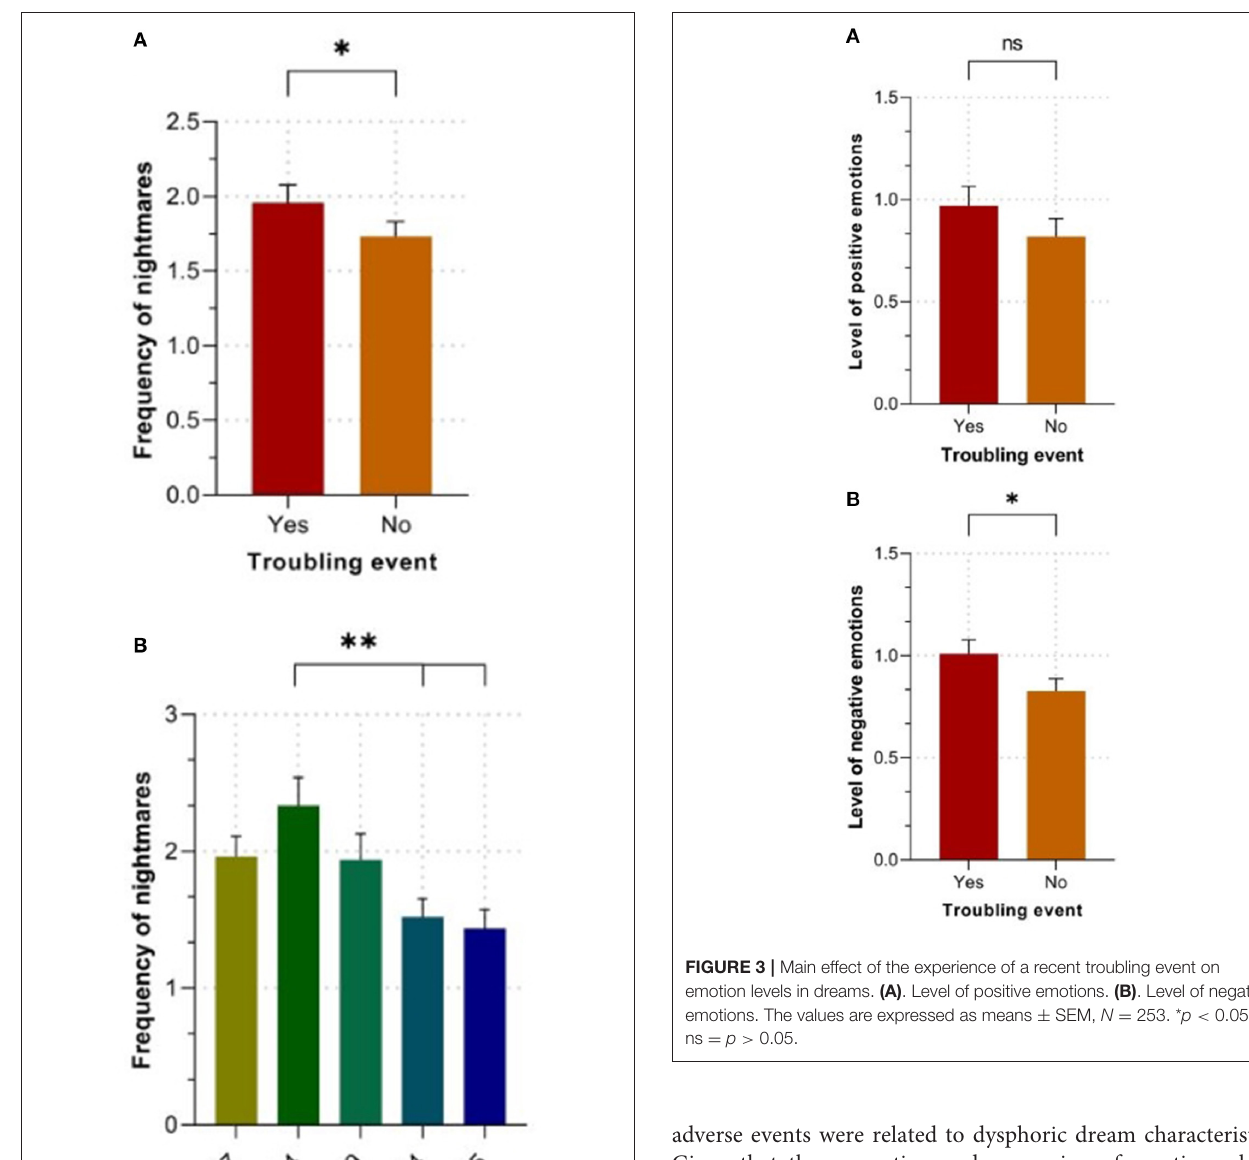
adverse events were related to dysphoric dream